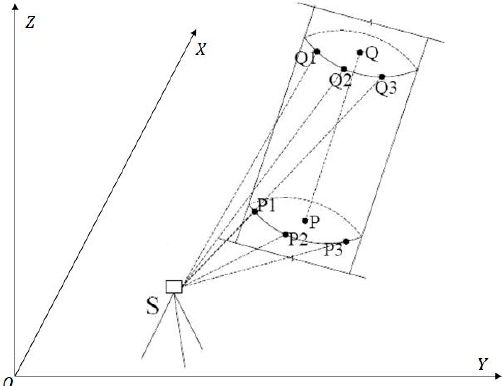
Figure 1. Inclination observation method of cylindrical steel.